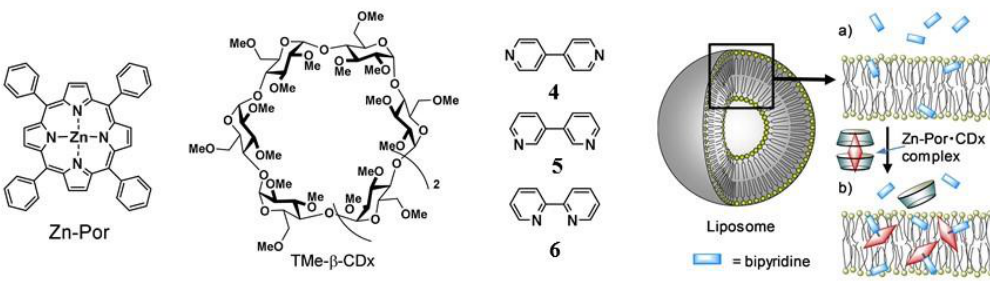
Figure 13. Formation of liposomes loaded with Zn-Por, TMe- β -CD and bipyridines. Retention of bipyridines in the lipid membranes ( a ) before and ( b ) after the addition of the Zn-Por • TMe- β -CDx complex. Reprinted with permission from [150]. Copyright 2019 Wiley Online Library.